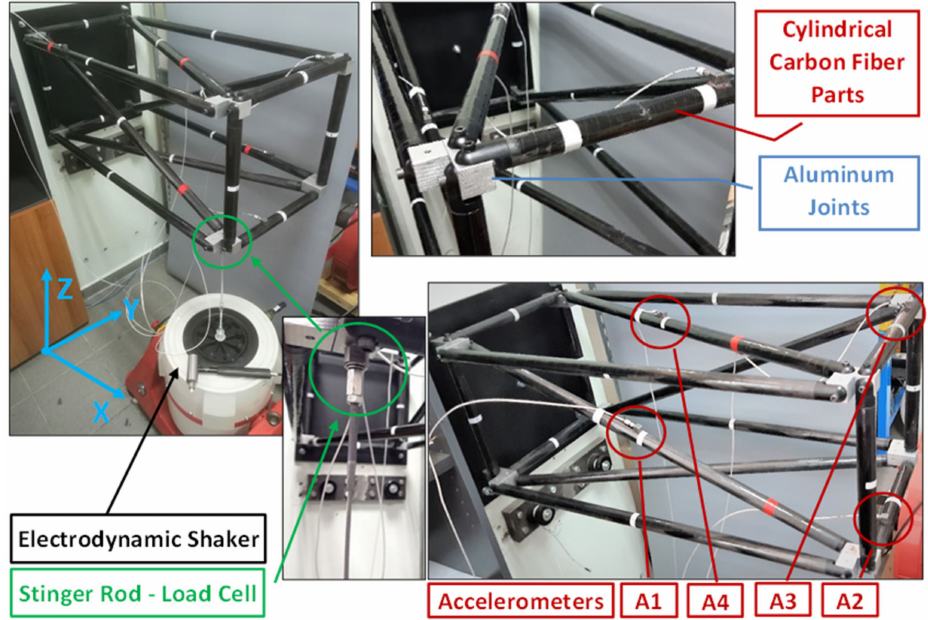
Figure 3. Experimental setup of the CFRP truss.